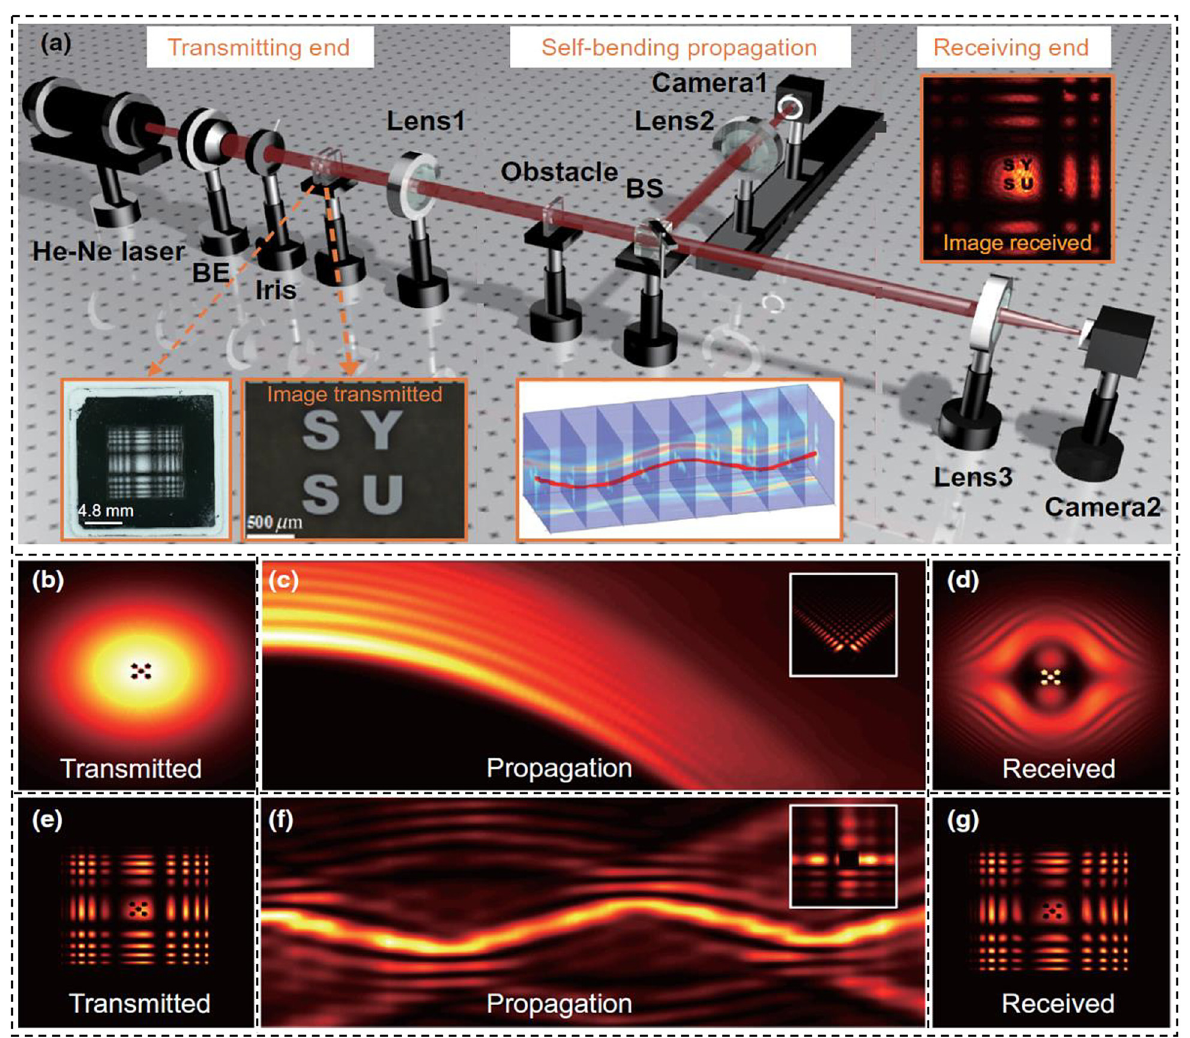
Figure 21: Image-signal transmission based on a nonconvex helical beam compared with the commonly used Airy beam. (a) Experimental implementation of optical image transmission based on a nonconvex accelerating beam. (b) The Fourier-space angular spectrum of the Airy beam with an encoded image. (c) Two-dimensional projection of the propagation dynamics of the Airy beam and (d) the retrieved angular spectrum of the Airy beam after blocking of its main lobe in the initial plane [as shown in the inset in (c)]. (e) – (g) Similar images as for (b) – (d) but for the case of a helical beam. BE, beam expander; BS, beam splitter [123]. Reprint permission obtained from